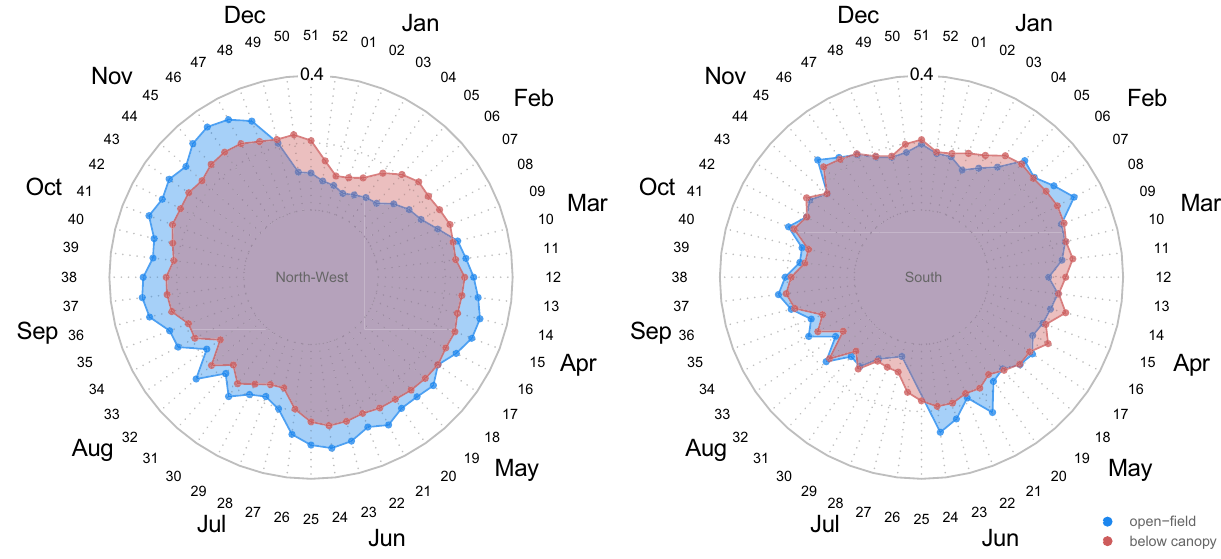
Figure 9. Average weekly soil near-ground moisture recorded in the open field (blue) and below the forest canopy (red) at the North-West (left) and South (right) aspects. Black numbers in the radar charts are the week number from the start of the year while gray numbers represent the soil moisture scale (m 3 /m 3